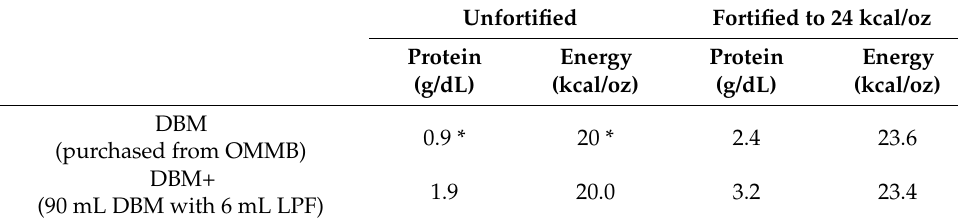
Table 1. Projected protein and energy concentrations.